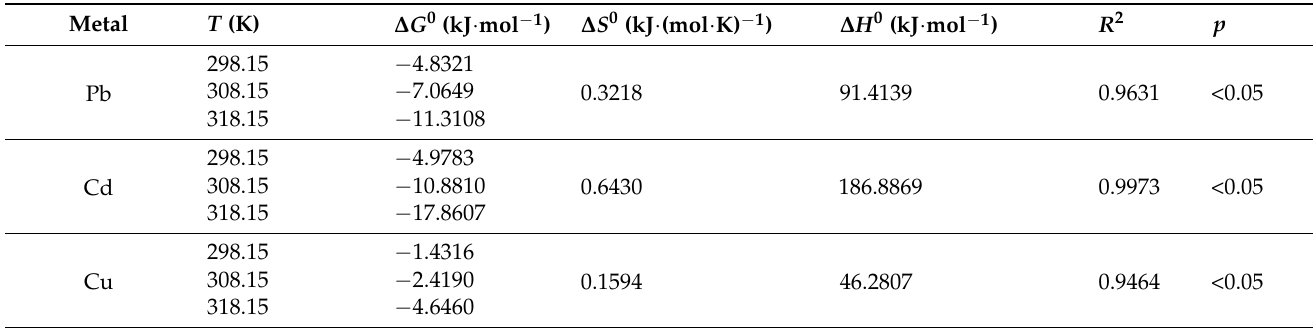
Table 4. Thermodynamic parameters of Cd 2+ , Pb 2+ and Cu 2+ onto